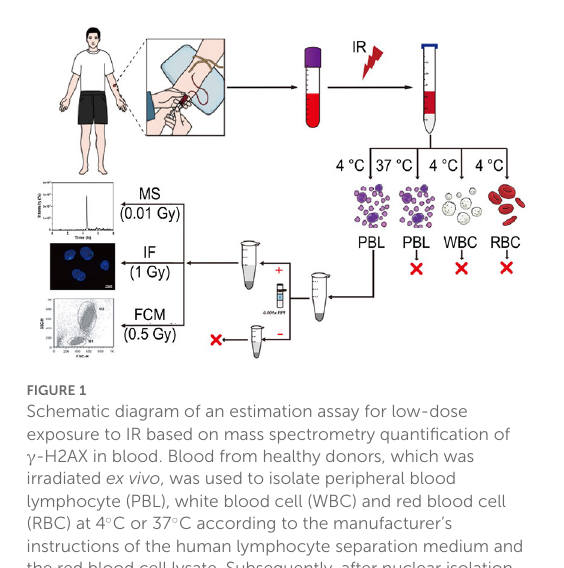
FIGURE1 Schematic diagram of an estimation assay for low-dose exposure to IR based on mass spectrometry quantification of γ -H2AX in blood. Blood from healthy donors, which was irradiated ex vivo , was used to isolate peripheral blood lymphocyte (PBL), white blood cell (WBC) and red blood cell (RBC) at 4 ◦ C or 37 ◦ C according to the manufacturer’s instructions of the human lymphocyte separation medium and the red blood cell lysate. Subsequently, after nuclear isolation with or without protease inhibitors, histone extraction, trypsin digestion in the solution, and desalting, the peptide sample from the carboxy terminus of H2AX was used for LC–MS/MS